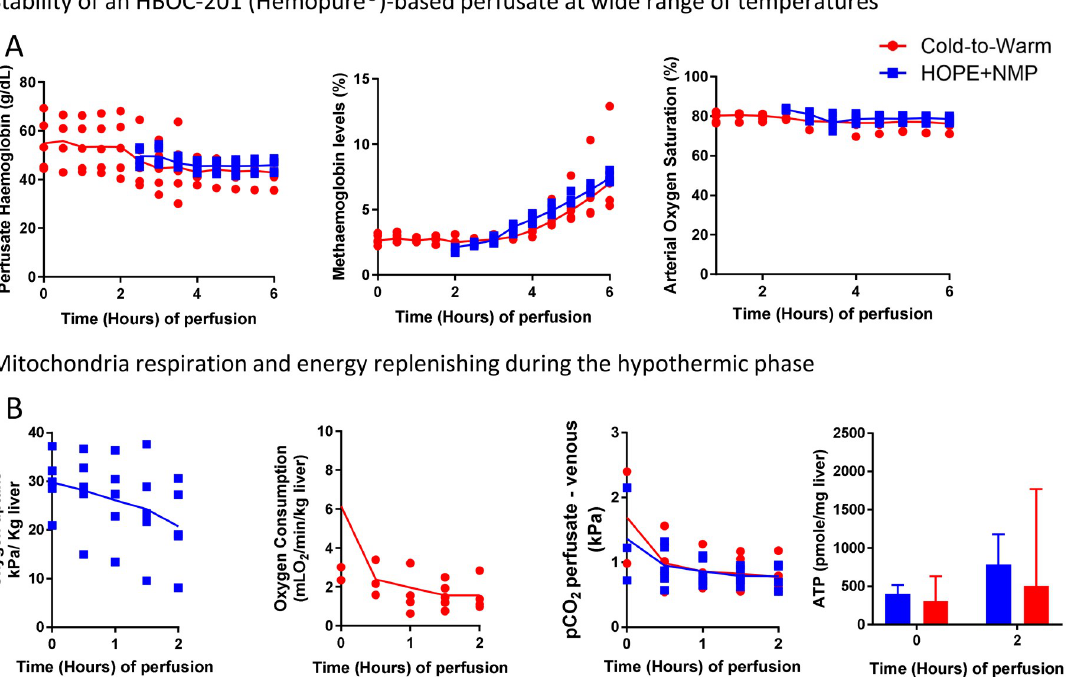
Fig 2. Stability of HBOC-based perfusate at different temperatures and its impact on mitochondrial function at hypothermic temperatures. Panel A shows on the left-hand graph that haemoglobin levels were stable during the D-HOPE phase, and after rewarming, they were similar to the HOPE+NMP group that received fresh HBOC-based perfusate. Methaemoglobin levels (middle graph) were stable during D-HOPE and increased slowly during the rewarming, reaching comparable levels to the HOPE+NMP group during the normothermic phase. Despite the increase in the levels of methaemoglobin, arterial oxygen saturation was constant throughout the perfusion. Panel B compares markers of mitochondrial respiration between the study groups. Both groups presented a downward trend in oxygen requirements (oxygen uptake—HOPE+NMP group and oxygen consumption—cold-to-warm group), with a similar drop in the release of carbon dioxide (CO 2 ) in the perfusate. Reflecting an efficient mitochondrial oxidative function, both groups replenished adenosine trisphosphate (ATP) stores during the hypothermic phase. In the graphs, dots represent individual organs at the time points, and the line is the median of the values for each group. For the bar graph, the median and interquartile range are